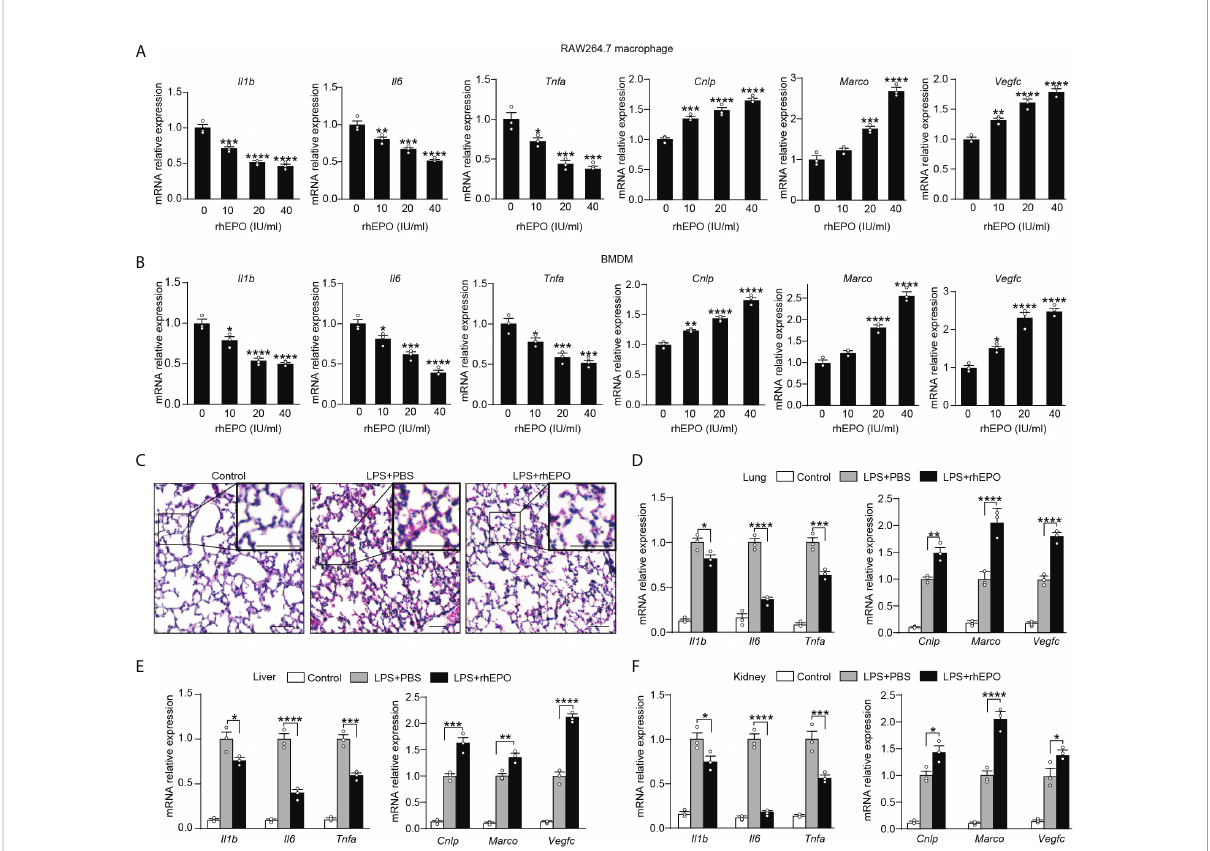
FIGURE 2 Exogenous EPO promoted endotoxin-tolerant re-programming. (A, B) : In vitro cultured RAW264.7 macrophages (A) or BMDMs from WT C57BL/ 6 mice (B) were incubated with different dose of rhEPO (0, 10, 20, and 40 IU/ml) in the presence of LPS (100 ng/ml) for 24 h, and then cells were washed with PBS twice followed by a secondary LPS stimulation (10 ng/ml) for 6 h; gene expression was measured by qRT-PCR (n = 3). (C – F) : WT C57BL/6 mice were intraperitoneally injected with LPS (1 mg/kg) together with rhEPO (5,000 IU/kg) or PBS for 24 h, and then mice were intraperitoneally given with a secondary LPS injection (10 mg/kg) for 6 h. Control mice were injected with PBS only. (C) : Lung specimens stained with H&E (bar = 100 m m, n = 3). (D – F) : qRT-PCR assay of gene expression in mice ’ s lung (D) , liver (E) , and kidney (F) (n = 3). Data are representative of three independent experiments. Results were expressed as means ± SEM. *P < 0.05, **P < 0.01, ***P < 0.001, and ****P < 0.0001. Statistics: one-way ANOVA (A, B) or two-way ANOVA (D-F) with Tukey ’ s post-hoc test for multiple